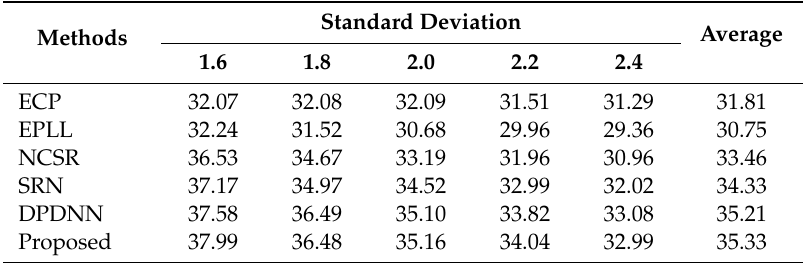
Table 5. The PSNR results of the deblurred images in the GoPro dataset.